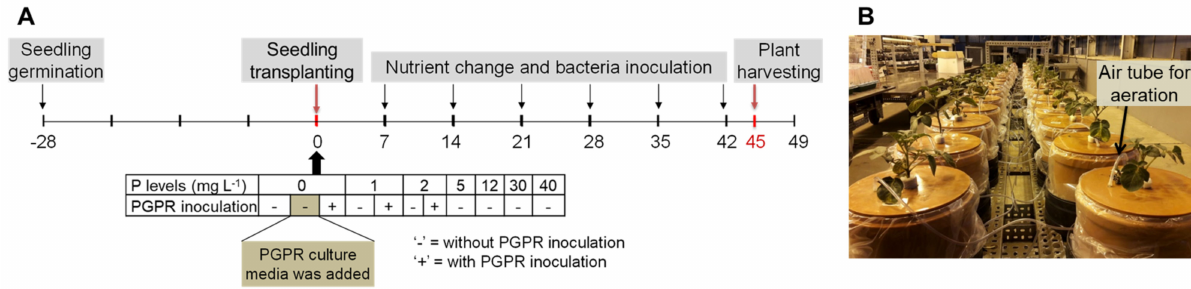
Figure 7. ( A ) Experimental design and timeline and ( B ) growing condition and pot arrangement in the